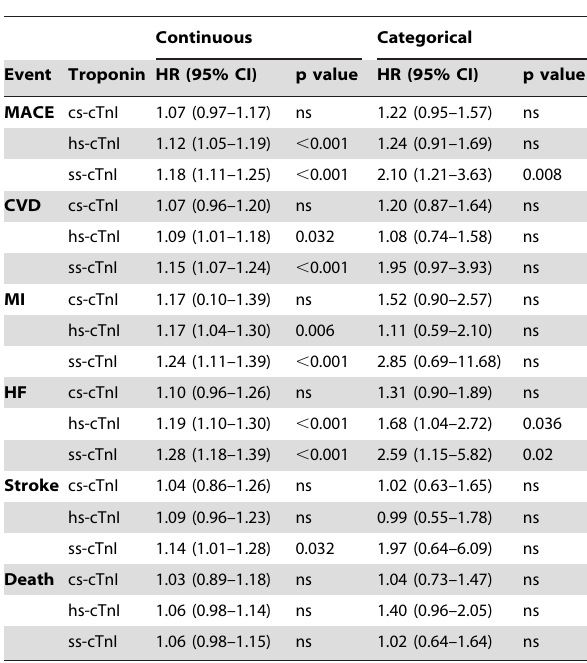
Table 3. Hazard Ratios from Cox Regression Models for Baseline Troponin Assessed by Contemporary-Sensitivity, High-Sensitivity and Super-Sensitivity Assays for Various Endpoints after Adjustment for the Framingham Risk